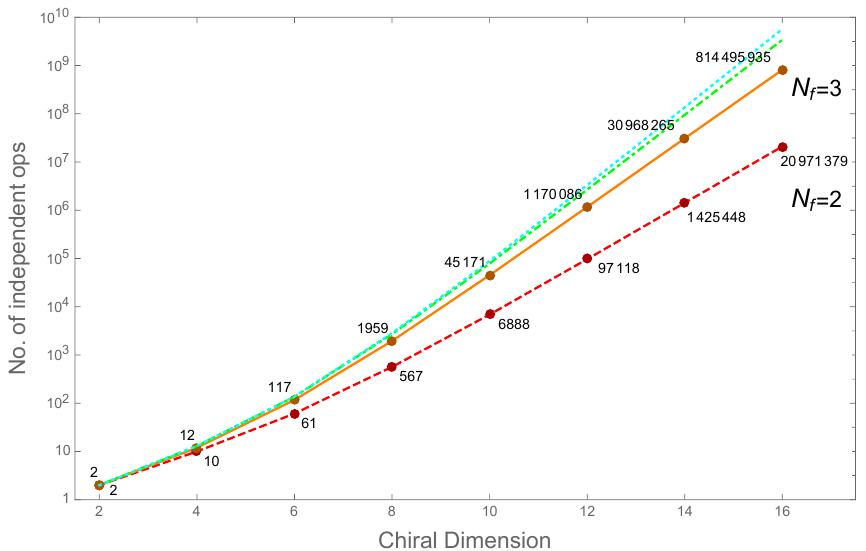
Figure 1 . The number of independent operators in the C -even P -even chiral Lagrangian as a function of chiral dimension, up to p 16 . Red dashed line, through points numbered 2 , 10 , 61 , . . . , corresponds to all operators in the case of two light quark flavours, N f = 2 . Orange solid line, through points numbered 2 , 12 , 117 , . . . , corresponds to all operators in the case of three light quark flavours, N f = 3 . The green dot-dashed and cyan dotted lines (without numbered dots) are, respectively, the cases N f = 4 and N f = 5 (the enumeration is provided in appendix E). N f = 2 chiral dim Total